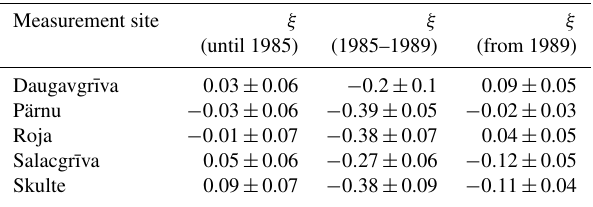
Table 2. The average value of shape parameter ξ as a result of sliding-GEV fit with a window of 30 years before 1985, 1985–1989, and after 1989 (Fig.